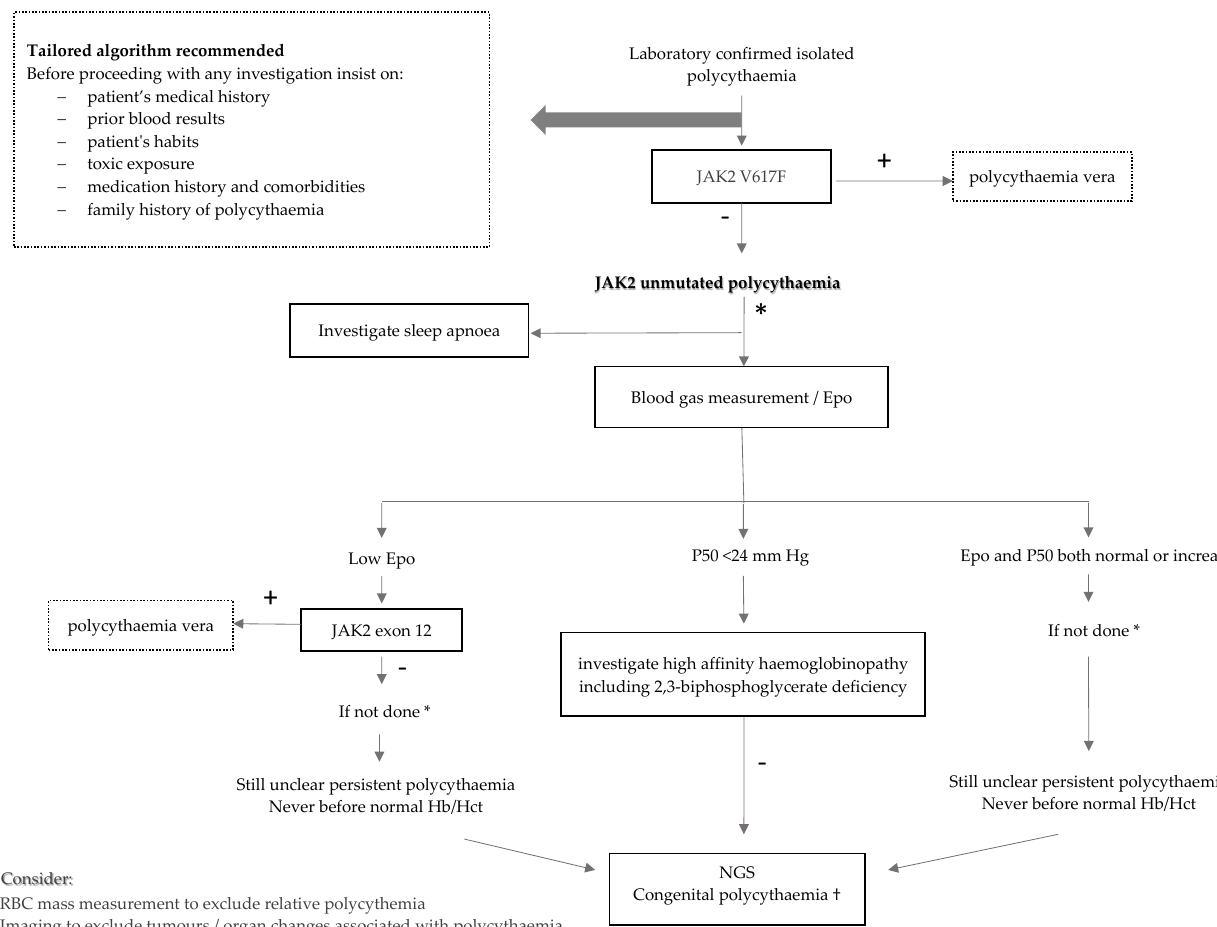
Figure 5. Our proposed diagnostic algorithm of JAK2 unmuted polycythaemia in adults. † Our 13-gene NGS panel includes: EPOR (exons 7,8), VHL (orf including exon 1’), EGLN1, EPAS1, EPO (including several regulatory regions), JAK2 (exons 9–16), BPGM, HBB, HBA1, HBA2, HIF3A, OS9, and SH2B3